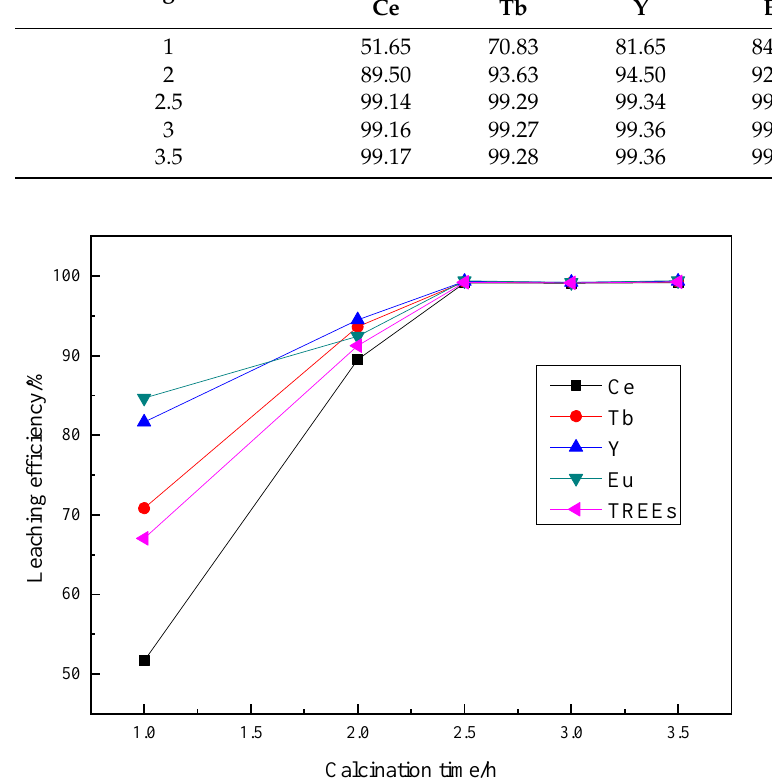
Figure 8. Influence of the roasting time on the REEs leaching efficiencies (oxygen concentration in the mixed gas of 0.4%, a roasting temperature of 700 ◦ C, a mass ratio of phosphor powder to alkali 1:3, a HCl solution concentration of 8 mol · L − 1 , an acid immersion temperature of 60 ◦ C, an acid leaching time of 1 h, and a liquid–solid ratio of 10:1.).